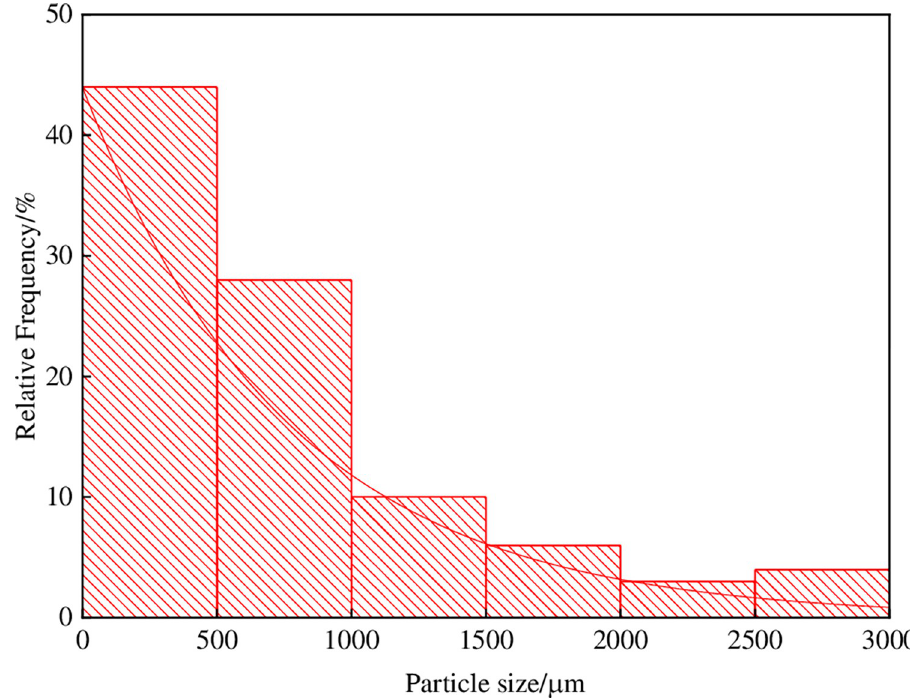
Fig 6. Particle size distribution of crushed gangue powder.